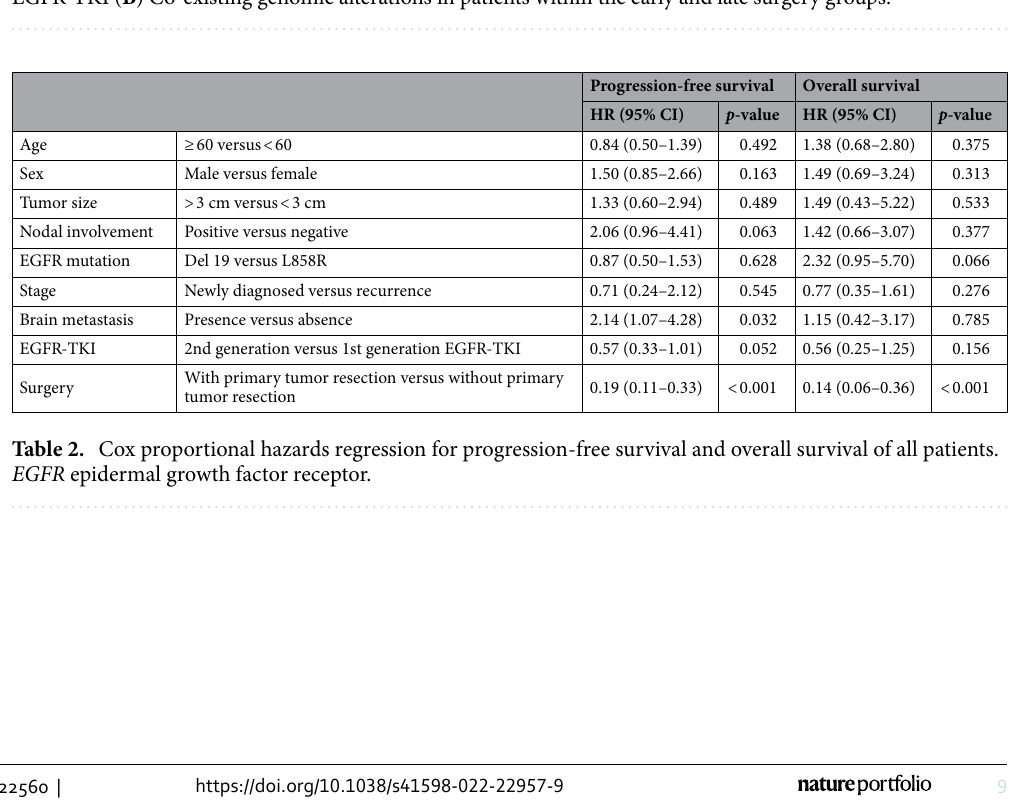
Figure 6. ( A ) Progression-free survival in patients who underwent early or late surgery after partial response to EGFR-TKI ( B ) Co-existing genomic alterations in patients within the early and late surgery groups.